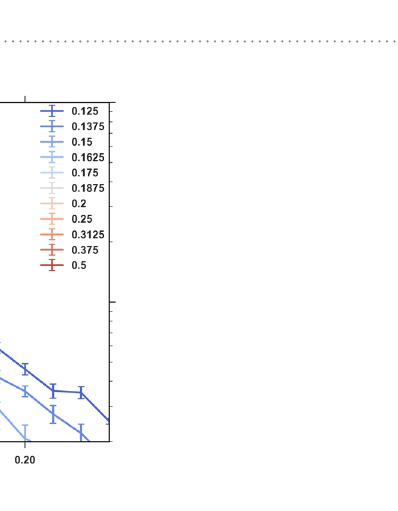
Figure 3. The logarithm of the mobility as a function of 1/T, for the determination of an effective gap T 0 , for the same range of ( OE / σ ) as in Fig. 2.